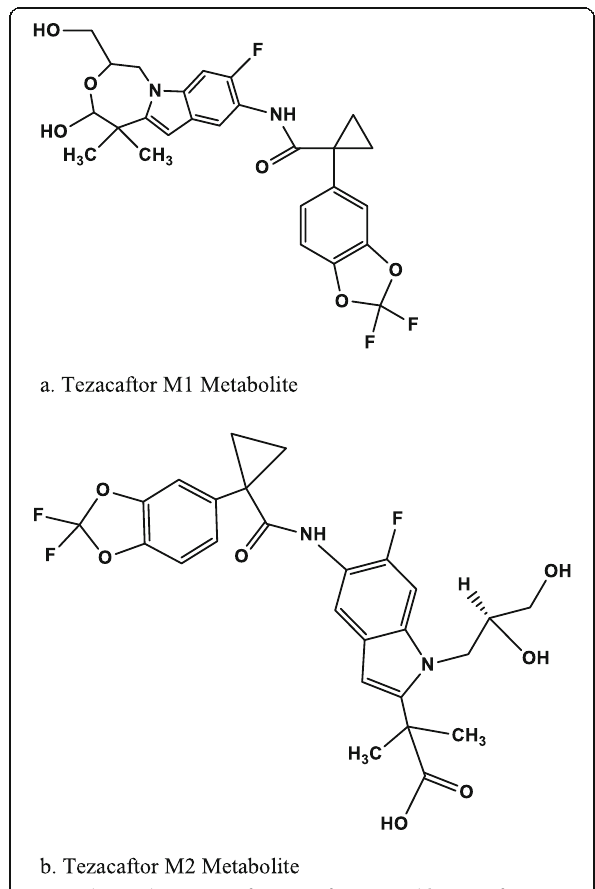
Fig. 3 Chemical structure of a Tezacaftor M1 and b Tezacaftor